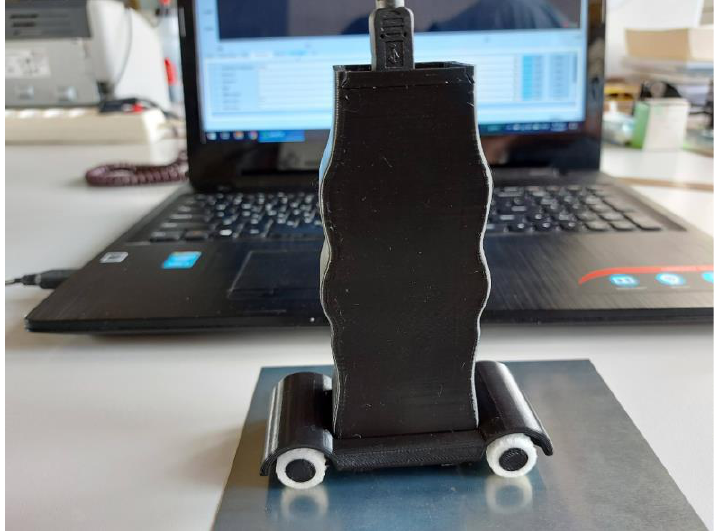
Figure 14. The final device in its 3D-printed packaging, connected to a laptop via a USB cable.